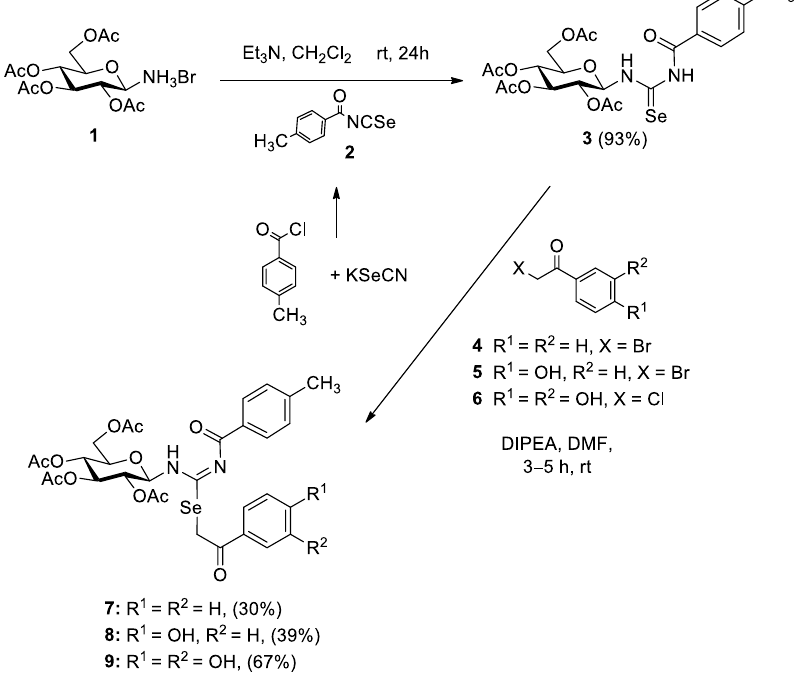
Scheme 1. Preparation of isoselenoureas 7‒9